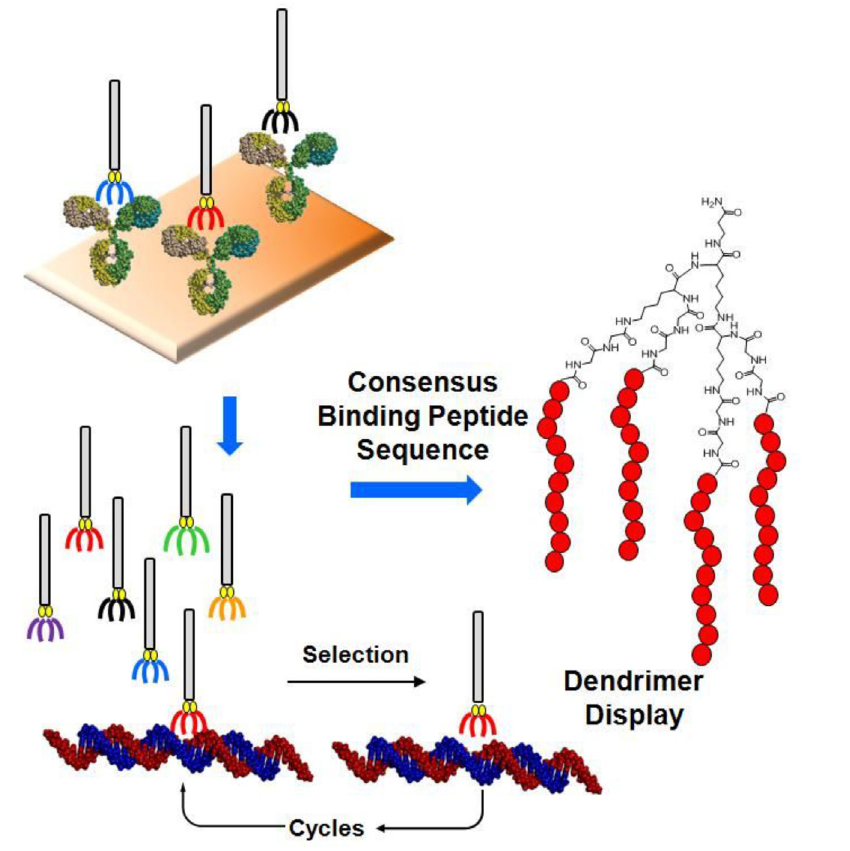
FIGURE 8 – Generation of phage display library used in biopanning and selection against two TF-Ag binding antibodies. Amplification and dendrimerization afforded a peptide vaccine that mimicked the carbohydrate